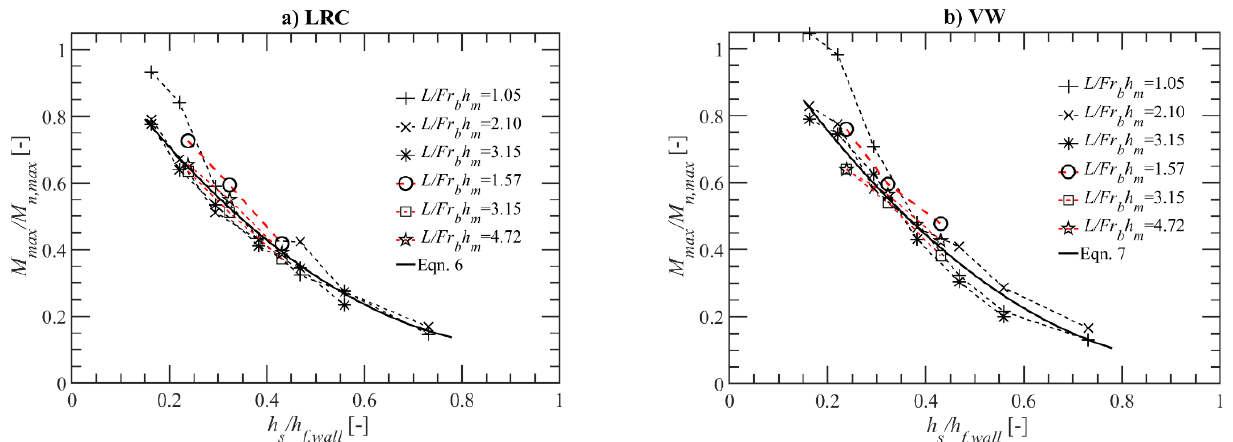
Figure 20. Effect of the height of the mitigation wall in the overturning moment variation on the inland structure.